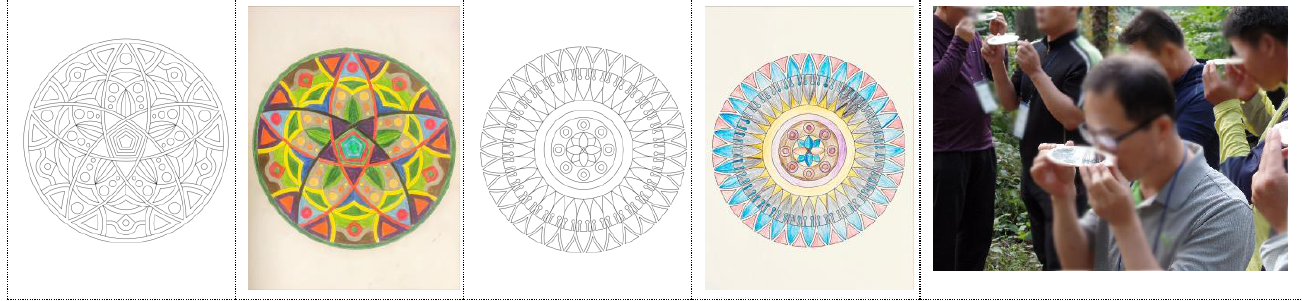
Figure 1. Samples of pre-line mandala, completed mandala drawings and sky mirror activity.